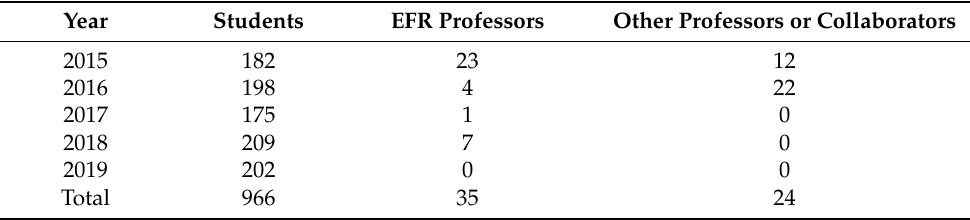
Table 1. Student participation and certifications by CONAPRA from 2015 to 2019.